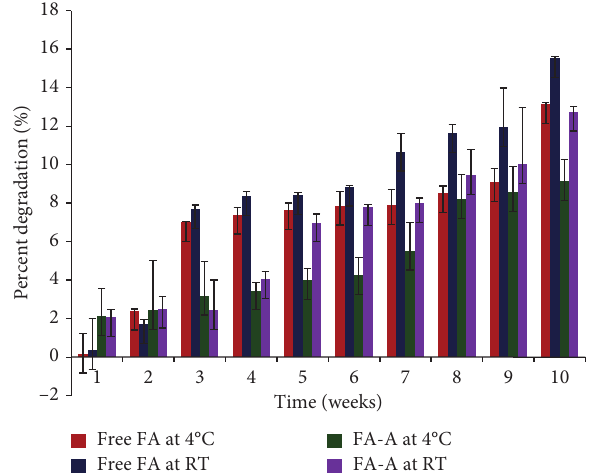
Figure 4: Percent degradation of folic acid as a result of tem- perature effect with time (Free FA: free folic acid; FA-A: folic acid encapsulated submicron